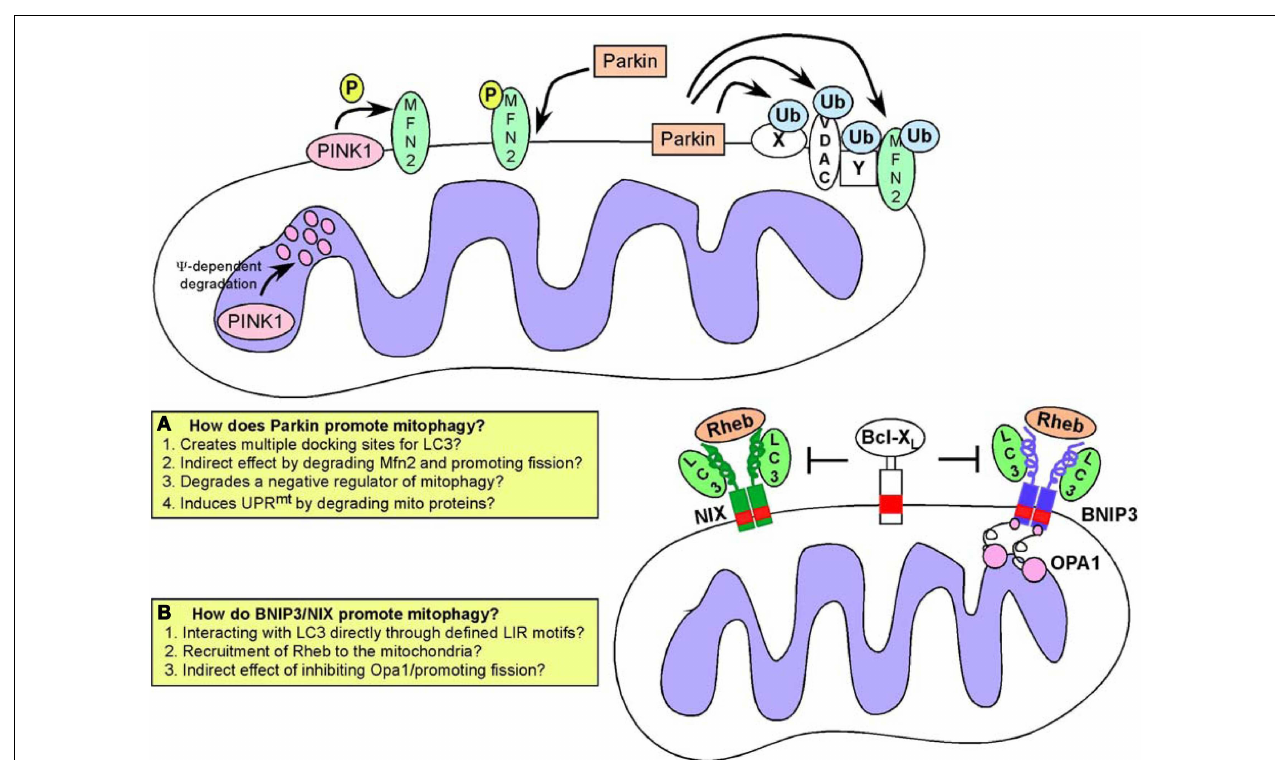
mitophagy is still a matter for debate, and possible explanations for how Parkin functions are highlighted in the inset box; (B) An alternative pathway involves the activity of BNIP3 and NIX, both of which are hypoxia inducible but also regulated by FoxOs, E2Fs, and p53. BNIP3 and NIX have both been shown to interact directly with processed LC3 through a conserved LIR motif in their amino terminal ends.This interaction has been proposed to explain how BNIP3 and NIX target mitochondria to the autophagosome. Both BNIP3 and NIX are also known to interact with Rheb, and with Bcl-2/Bcl-X L but the significance of these interactions for mitophagy are not